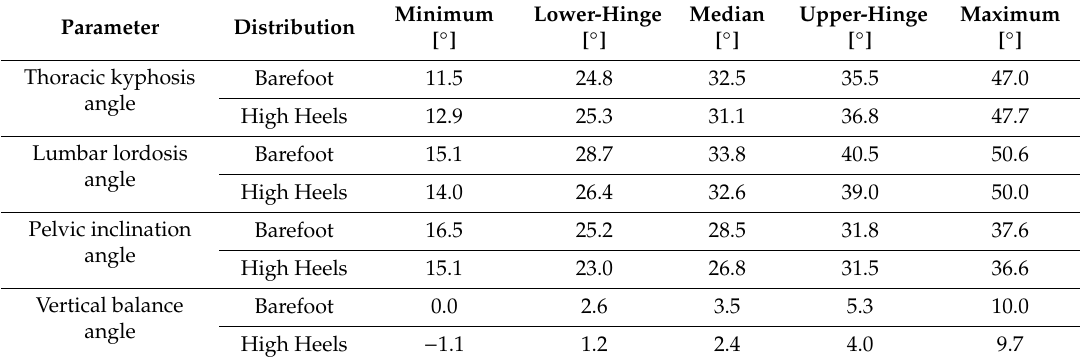
Table 1. Summary of distributions for all the angles.